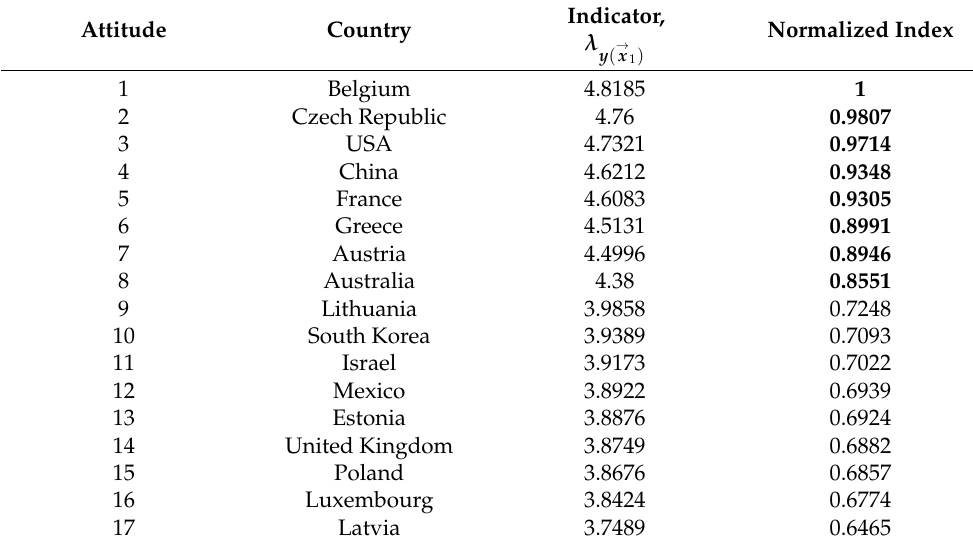
Table 3. Rating of countries according to the social component of the global inclusive circular